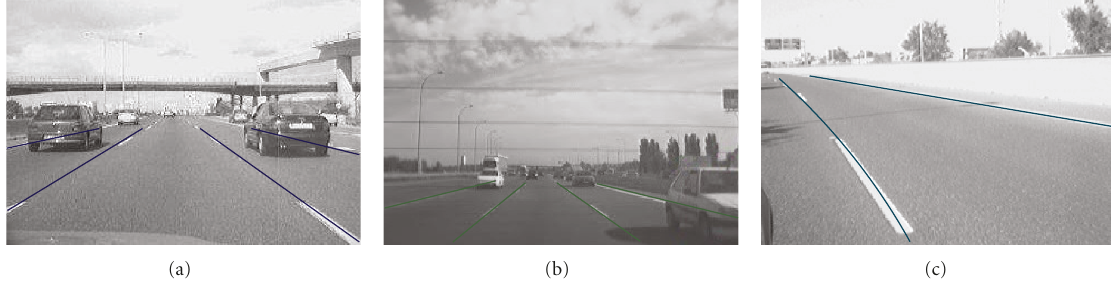
Figure 5: Vehicle searching area as a result of the lane markings analysis for forward, rear and side modules.